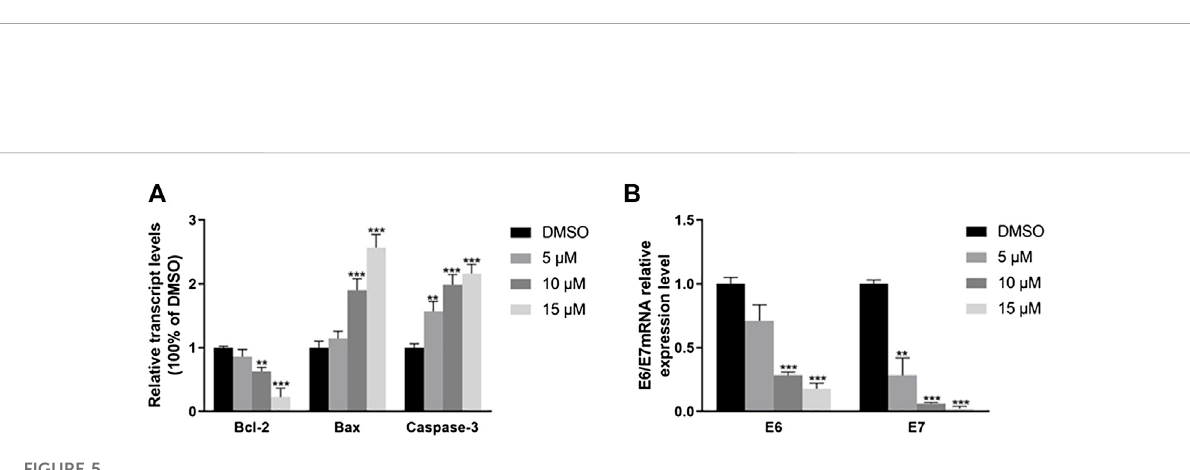
FIGURE 4 Effects of RPDPRH on cell-apoptosis progression in CaSki cells. Note: (A) : Flow cytometry analyses of apoptosis induction in CaSki cells after treated by RPDPRH for 24 h (B) : the total apoptosis rate. Compared with the DMSO control group, pp p < 0.01, ppp p < 0.001, ( ‾ x ± s, n = 3). (C) : The living cells (LL), early apoptotic cells (LR), late apoptotic (UR), and necrotic cells/fragments (UL) rate of CaSki were analysed.